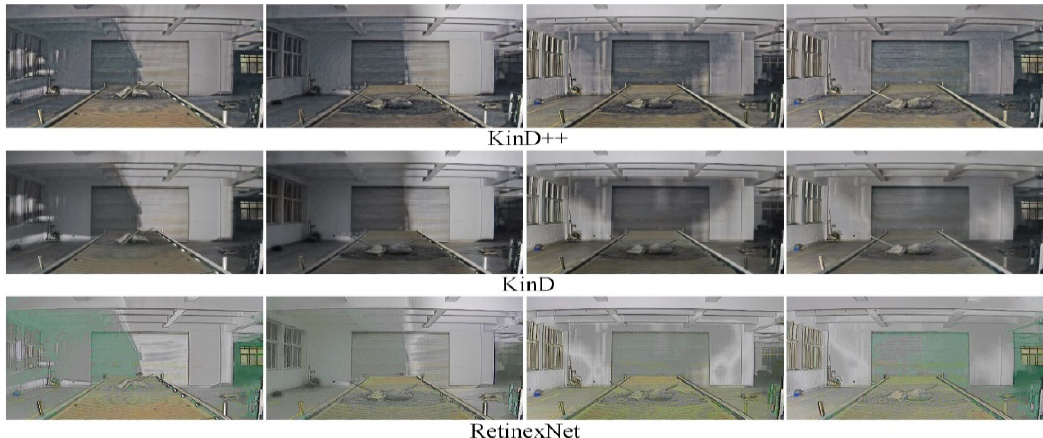
Figure 10. Enhancement of images in the dark by deep learning algorithms.